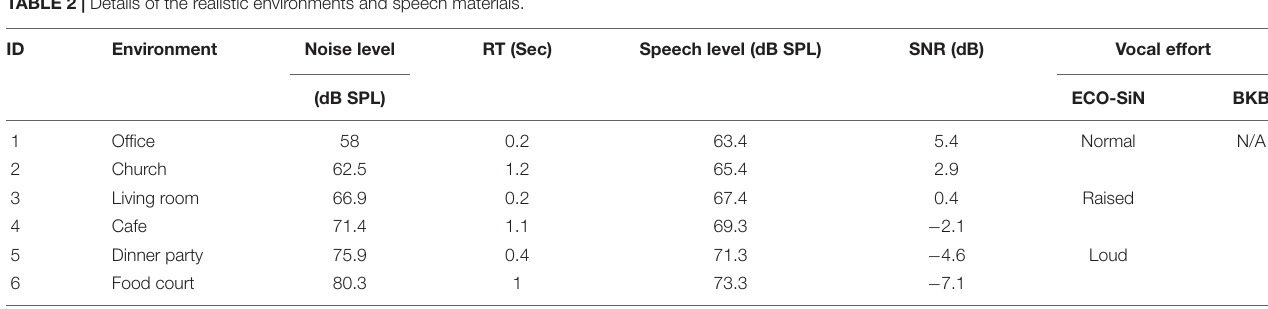
Numbers are rounded.